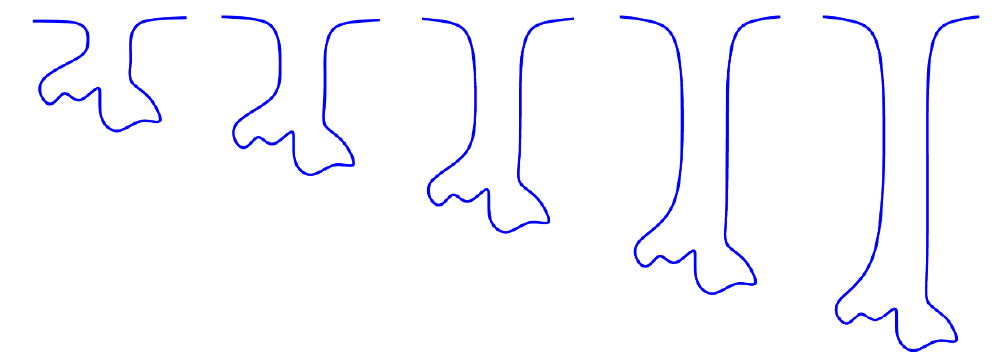
Figure 1 . A schematic description of a scaling geometry. The physical size of the bubbles remains the same whereas the throat of the solutions deepens